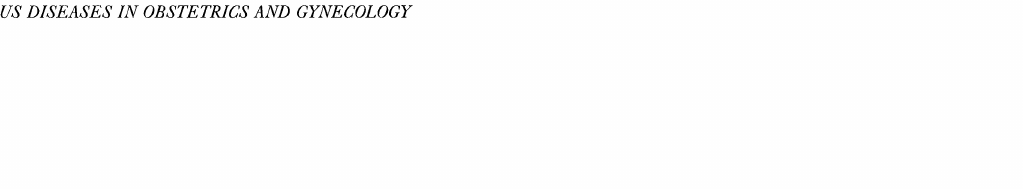
Fig. 2. A perspective on labor emphasizing infection and inflammation. Microorganisms from the lower genital tract transgress cervical barriers and gain entry into the cho- riodecidual space. Microorganisms within the cervix stimu- late the local production of proinflammatory cytokines in- cluding IL-I, IL-6, IL-8 and TNF, which lead to neutrophilic infiltration, prostaglandin production and cervical softening and effacement. Microorganisms in the choriodecidual space leads to recruitment of maternal and fetal macro-